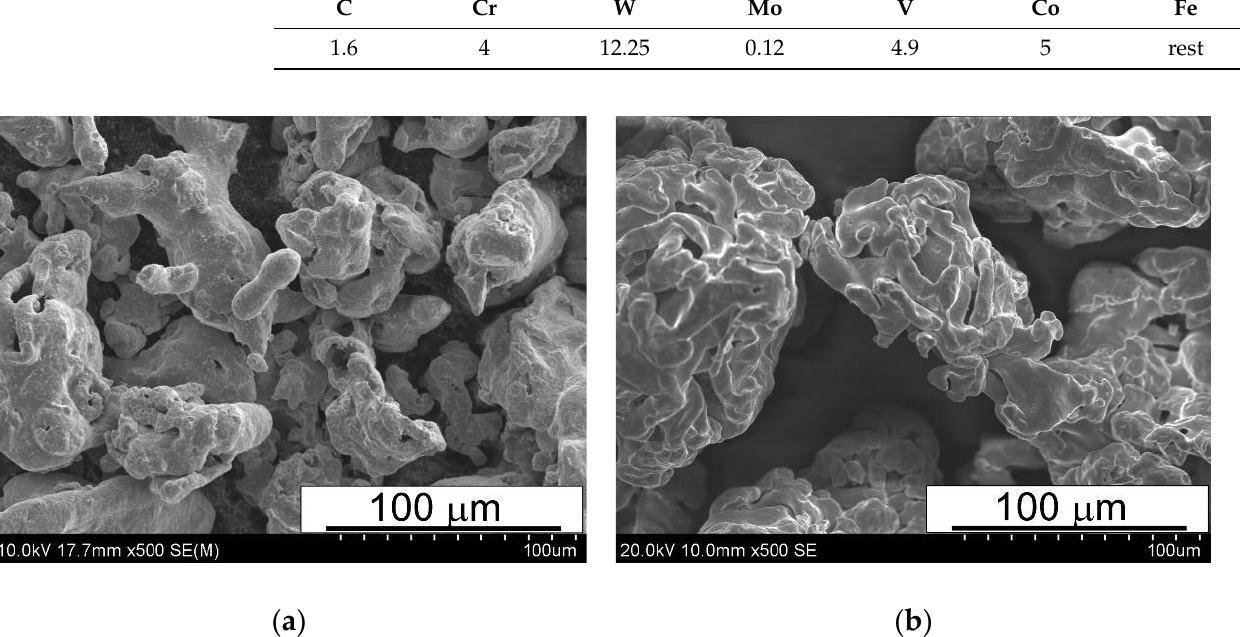
Figure 1. SEM morphologies of powders: ( a ) T15 HSS, ( b ) NC 100.24 iron.